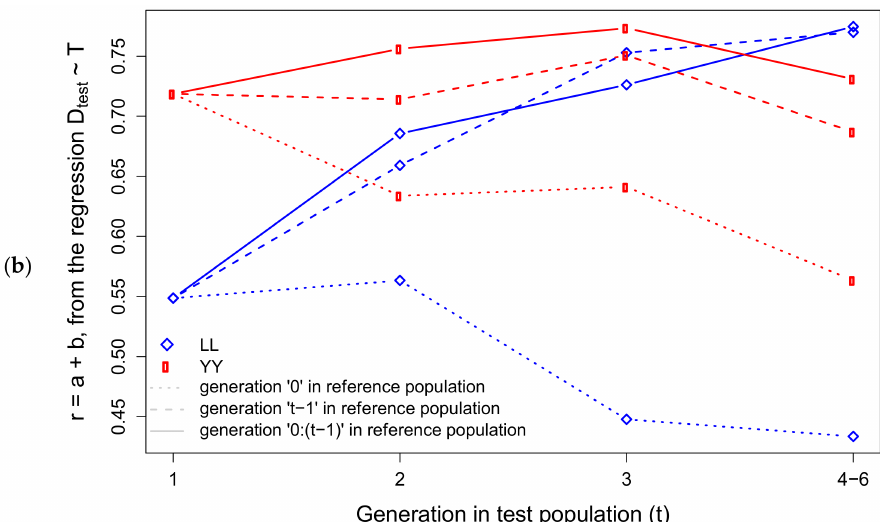
Figure 4. Genomic relationships between individuals in reference and test populations by breed (Landrace (LL) and Yorkshire (YY)) and generations (1 to 4–6). Panel ( a ) presents the average